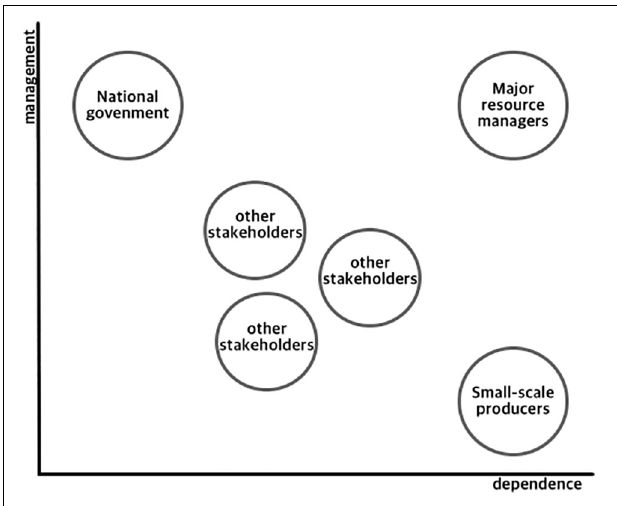
FIGURE 2 | A schematic illustration of stakeholder groups’ power